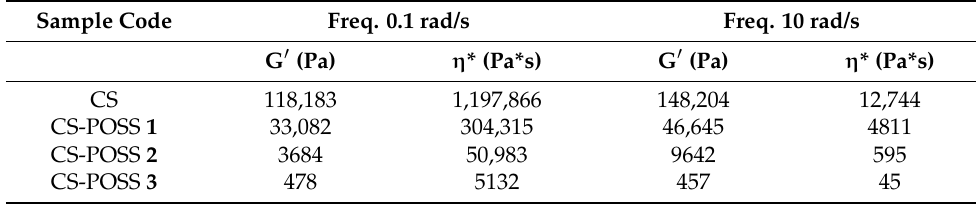
Figure 4. Complex viscosity ( η*) ( a ) and G ′ modulus ( b ) vs. frequency for CS and CS-POSS samples, at different POSS concentrations. Table 1. Sample code and rheological data at two frequencies.